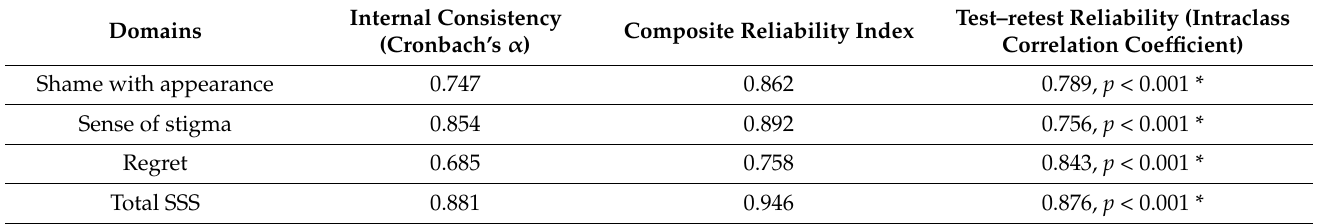
Table 7. The internal consistency, composite reliability index and test–retest reliability of the